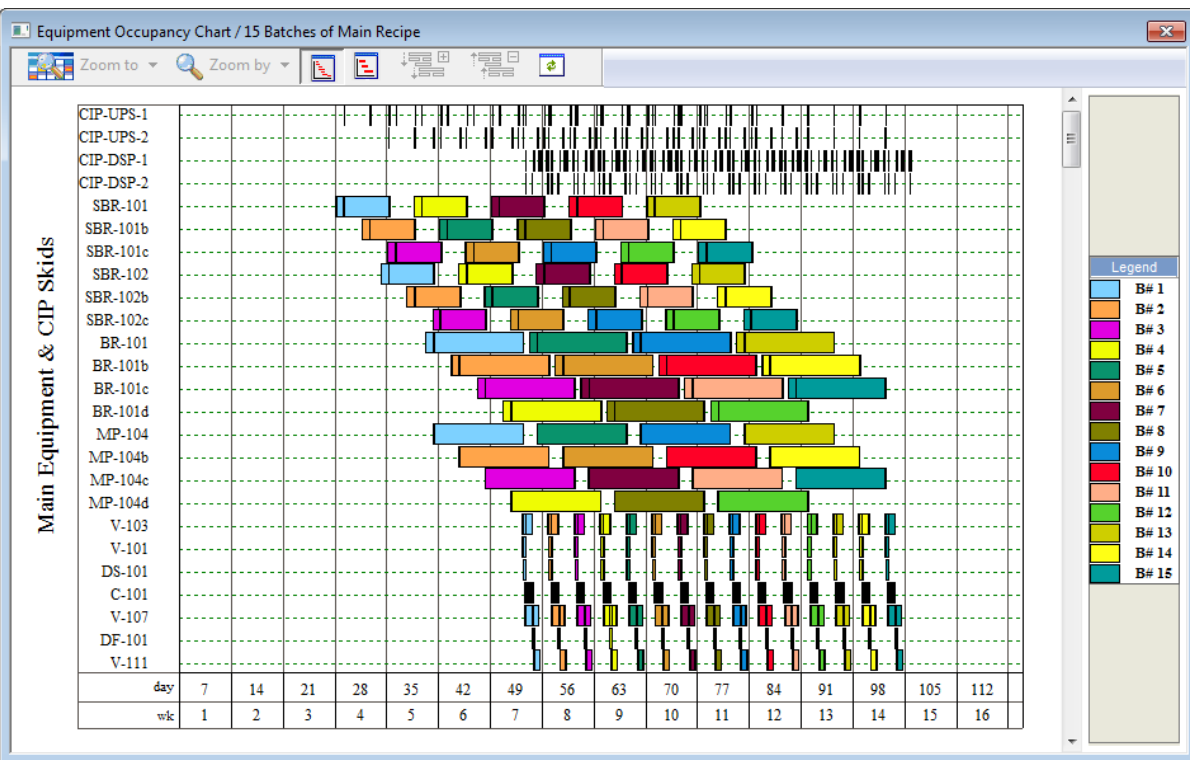
Figure 4. Four bioreactor trains feeding one purification